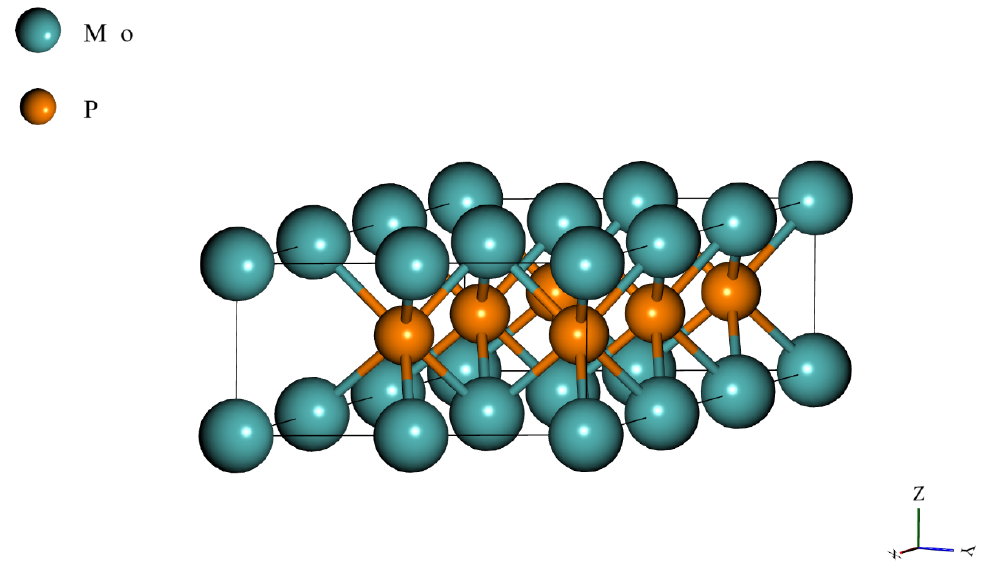
Figure 1. Structure of a monolayer of hexagonal MoP produced by DFT simulation.